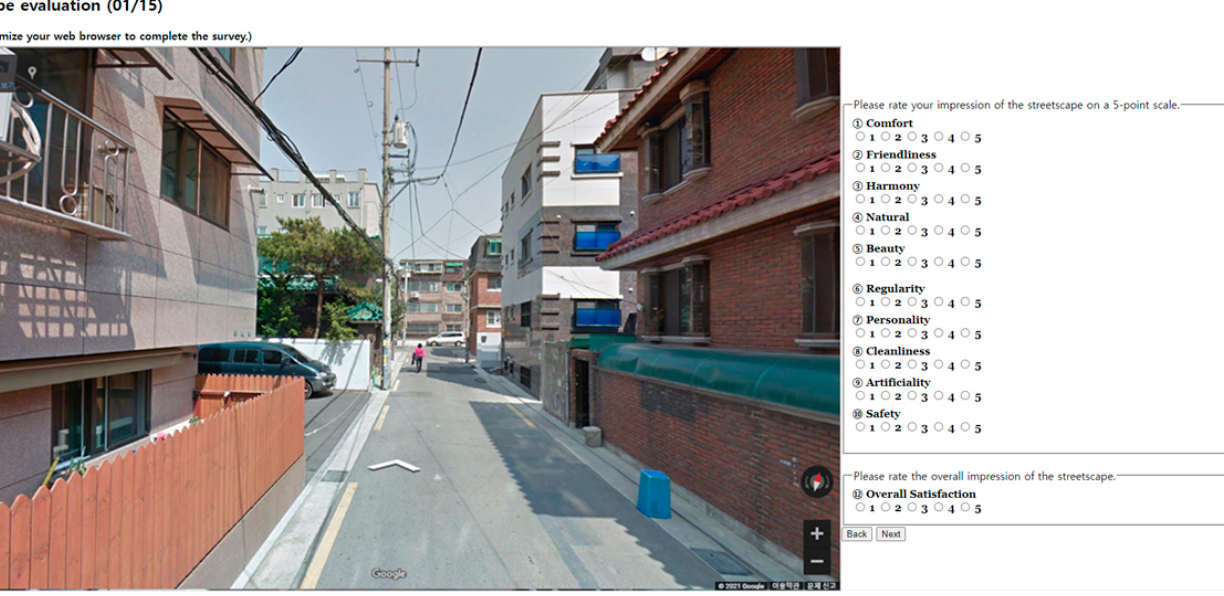
Figure 3. Example of the web-based urban streetscape evaluation.